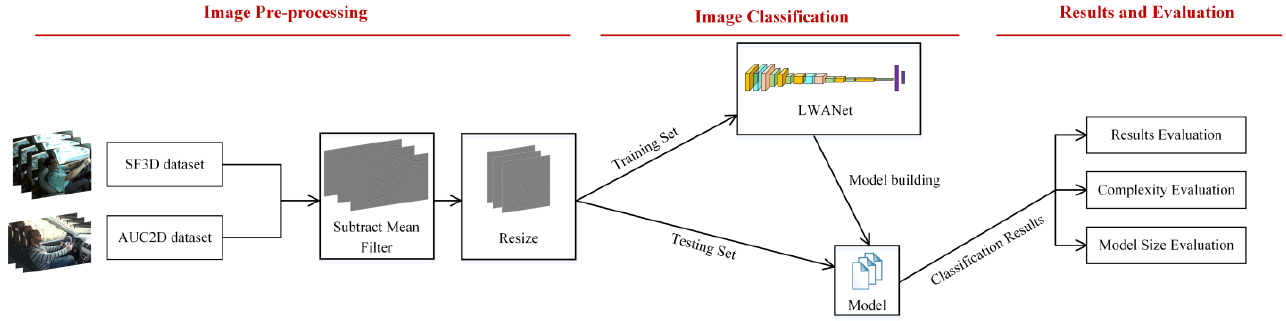
Figure 7. Overall flowchart.